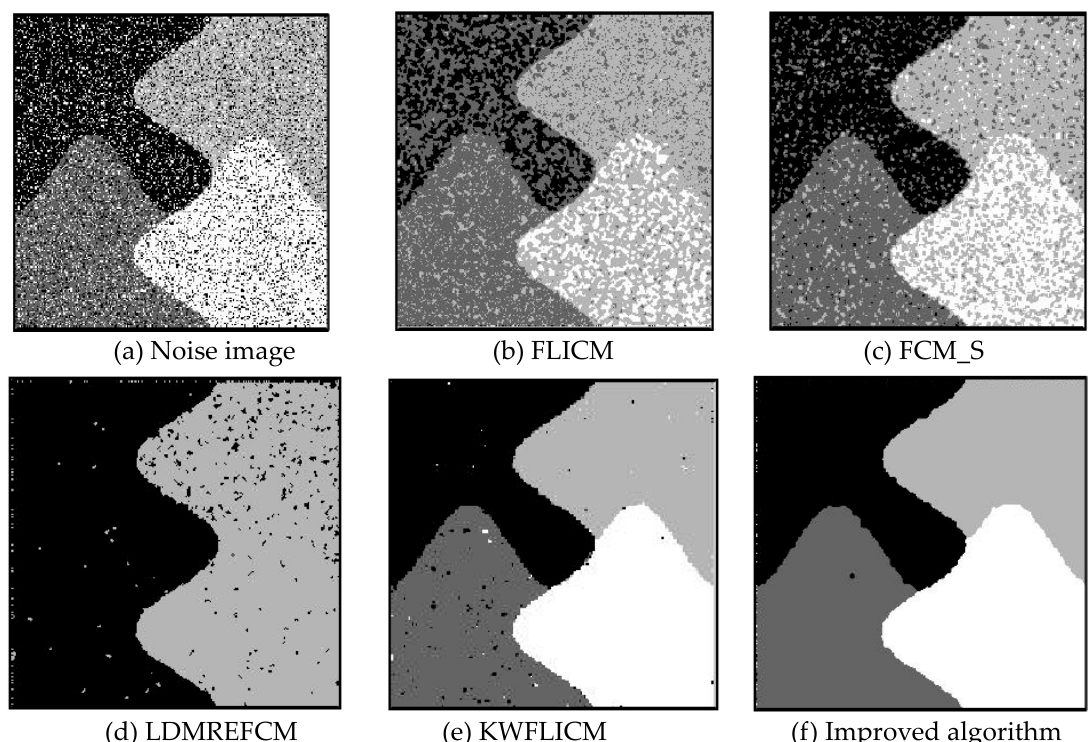
Figure 9. Images containing four artificial categories disturbed by salt-and-pepper noise ( a ) and the segmentation results ( b – f ).